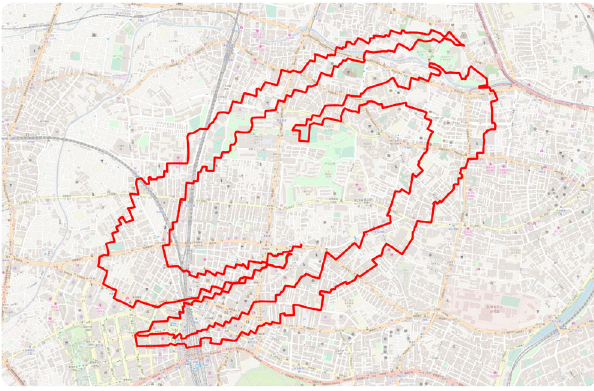
The SIGGRAPH logo as a GPS route on top of Tokyo computed using our